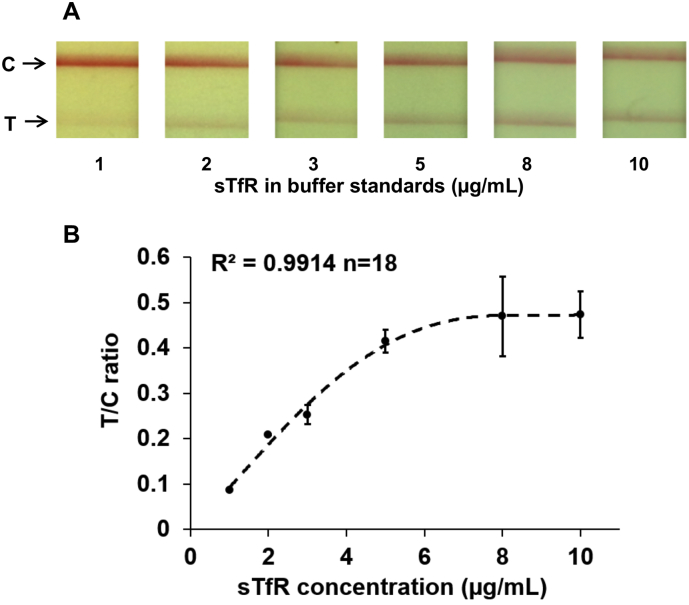
(A) Representative images of the test and control lines on the sTfR test strip for a range of sTfR concentrations in spiked-buffer standards (B) Calibration curve with T/C values for a range of sTfR concentrations in spiked-buffer standards.